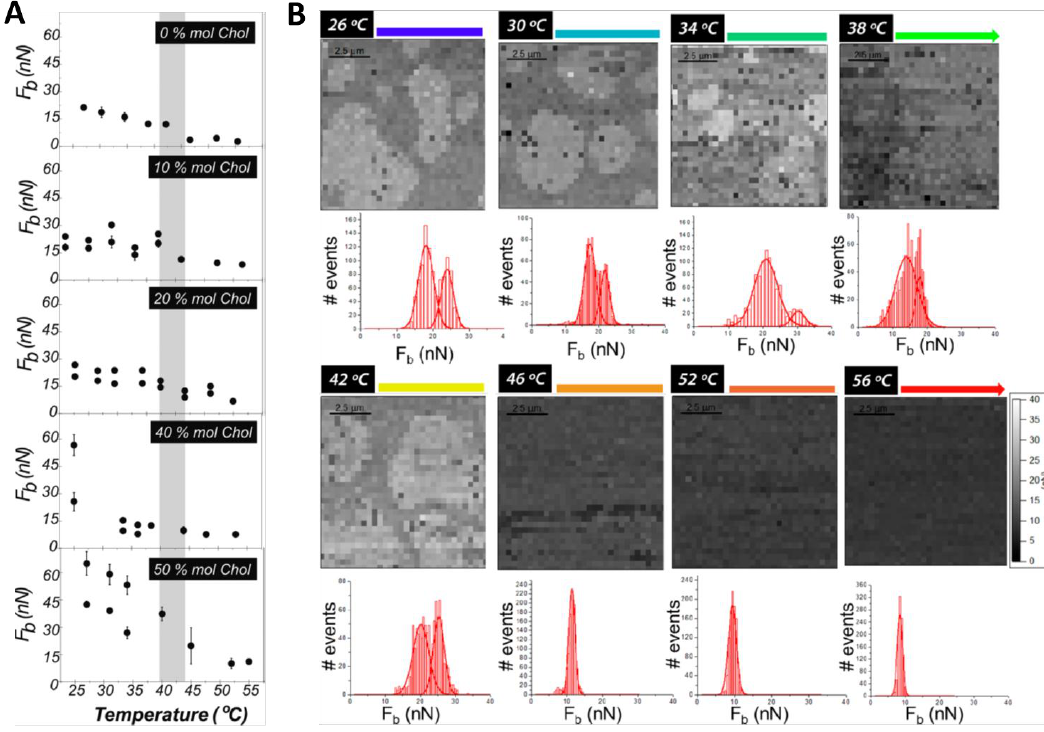
Figure 4. ( A ) Mean F b value of DPPC:Chol SPB in 10 mM HEPES, 20 mM MgCl 2 and 150 mM NaCl, pH 7.4, with various Chol contents, as a function of temperature. The shadowed vertical line marks the temperature range where the main transition in pure DPPC occurs. For DPPC:Chol SPBs with 40 and 50 mol % Chol, although not detected in DSC of DPPC:Chol vesicles, a transition occurs around 42–45 ◦ C; ( B ) F b maps and distributions for DPPC:Chol SPB with 10 mol % Chol, in 10 mM